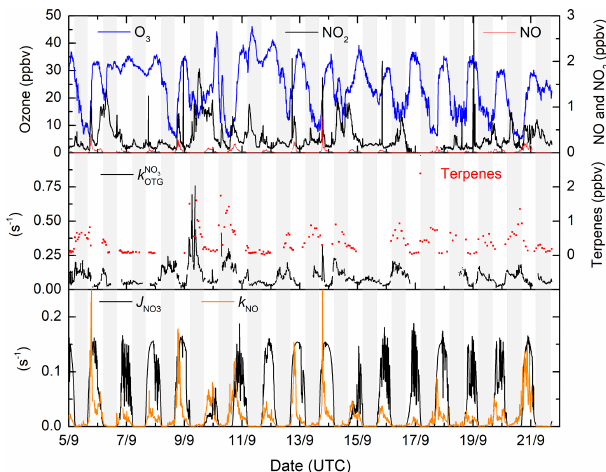
Figure 2. Time series of the NO 3 precursors (NO 2 and O 3 ), the NO 3 reactivity to organic trace gases ( k NO 3 loss constants for its photolysis ( J NO during IBAIRN. Grey shaded regions are